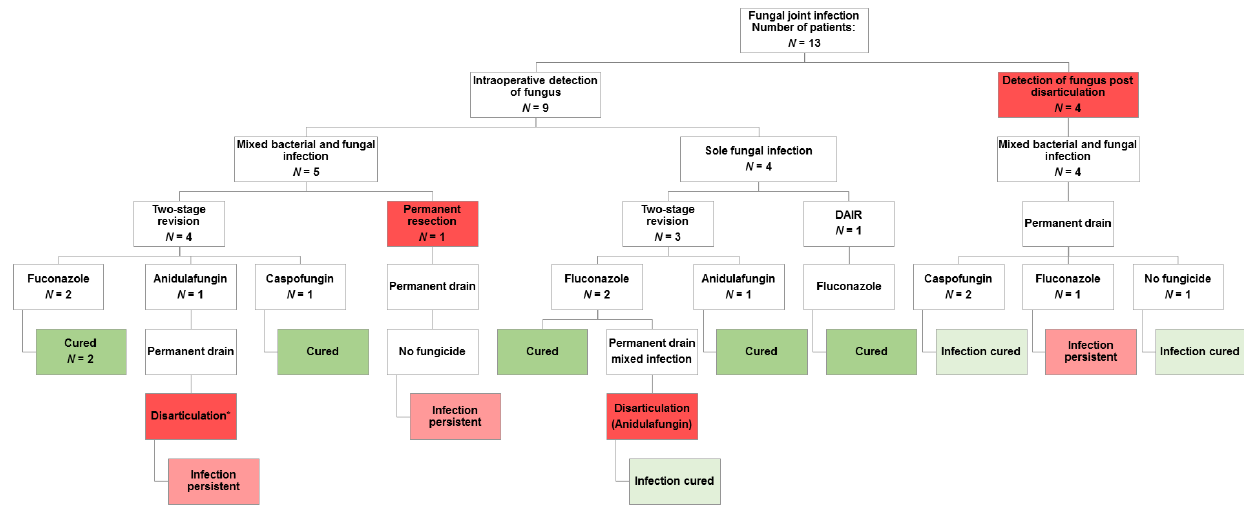
Figure 4. Detailed presentation of cases with periprosthetic infection and candidiasis.